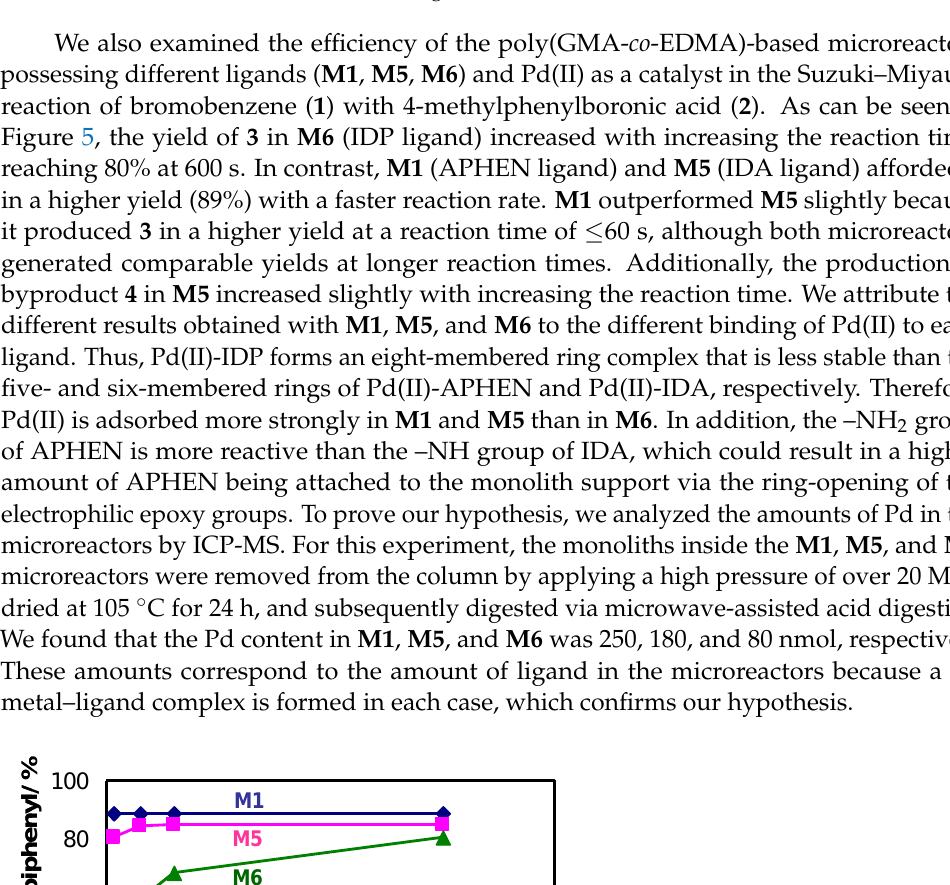
Figure 4. Effect of metal catalysts on the reaction of bromobenzene with 4-methylphenylboronic acid. Other conditions were similar to those in Figure 3.